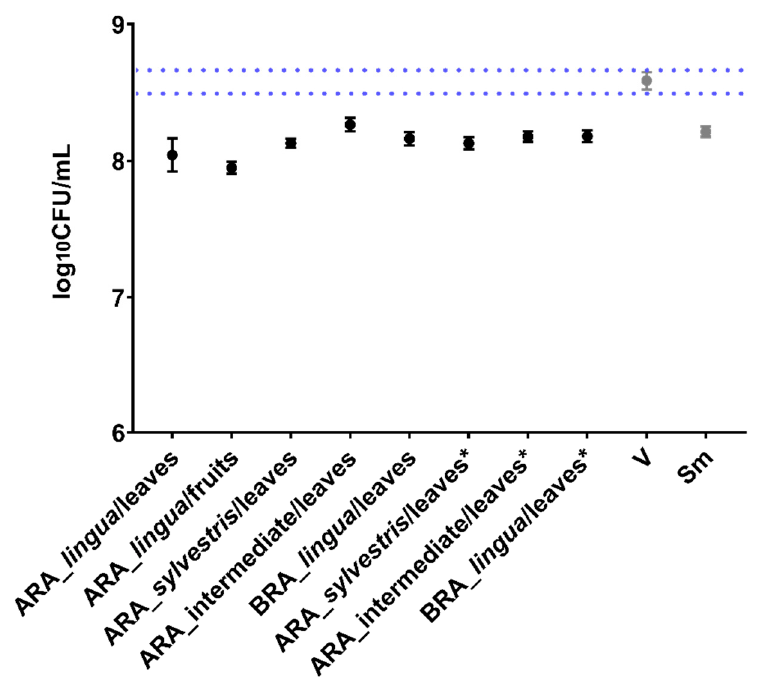
Figure 1. Antimicrobial activity of C. sylvestris crude extracts against S. mutans . Log 10 CFU data from planktonic cells treated by crude extracts (500 µg/mL). The central data are the mean, and the error bars are the confidence interval (95% CI). The dotted lines use vehicle data to compare the effectiveness of tested treatments. The growth control (no treatment) is represented as Sm for S. mutans and V for the vehicle control (with the concentration in each well being 1.75% EtOH and 0.31% DMSO). The asterisk indicates the raw extracts with the pH adjusted to a value close to the vehicle. The experiments were performed in triplicate on two separate occasions ( n = 2).